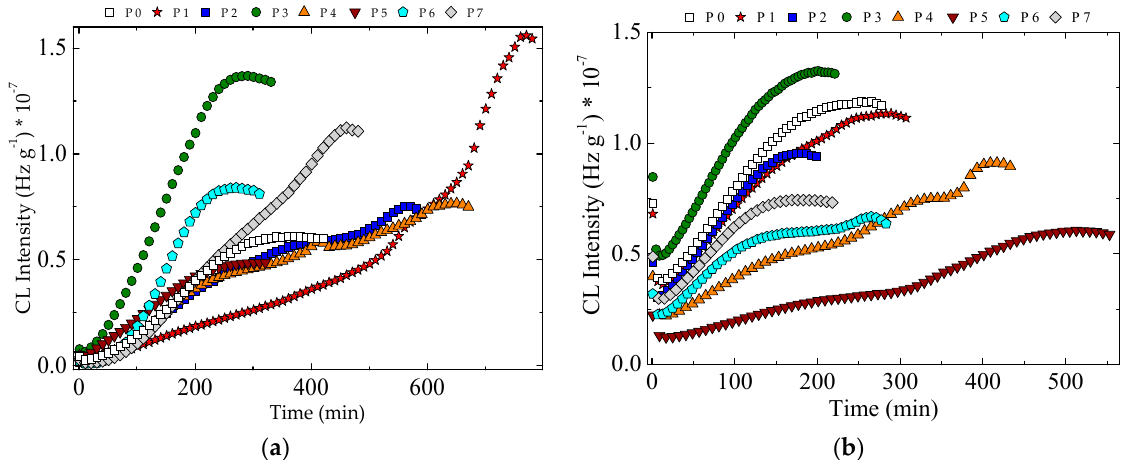
Figure 2 . Isothermal CL spectra recorded on PP loaded with various substituted POSS powders. Temperature: 150 °C. ( a ) nonirradiated samples; ( b ) hybrids exposed to 50 kGy.